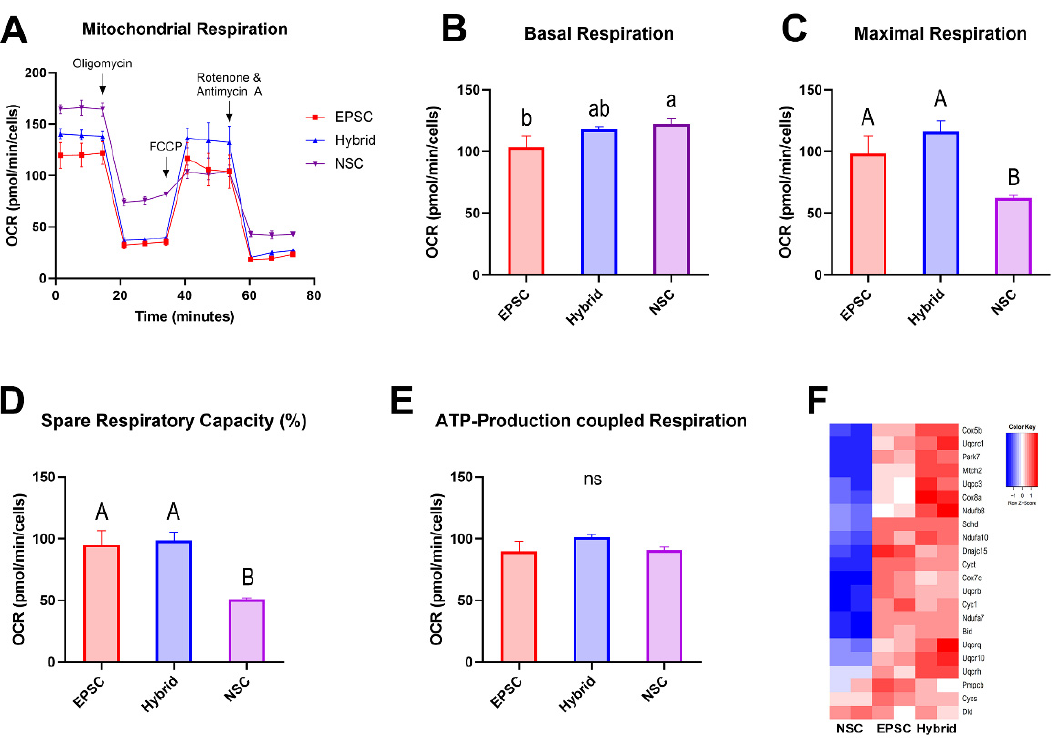
Figure 6. Metabolic remodeling in EPSC-NSC hybrid cells. ( A ) Measurement of oxygen consumption rate (OCR) in EPSCs, NSCs, and EPSC-NSC hybrid cells using Seahorse XFp analyzer. ( B – E ) Measurement of ( B ) basal respiration, ( C ) maximal respiration, ( D ) spare respiratory capacity (%), and ( E ) ATP-production-coupled respiration. Data are presented as the mean ± SD for n = 3 wells/group. ns, non-significant. A,B Uppercase and a,b lowercase indicate significant differences among different groups at p < 0.01 and p < 0.05. Data were analyzed using one-way ANOVA and Tukey’s post hoc with SAS ® software, version 9.4, (Institute of INC, Cary, NC, USA). ( F ) Heatmap of expression of genes categorized in ATP-synthesis-coupled electron transfer